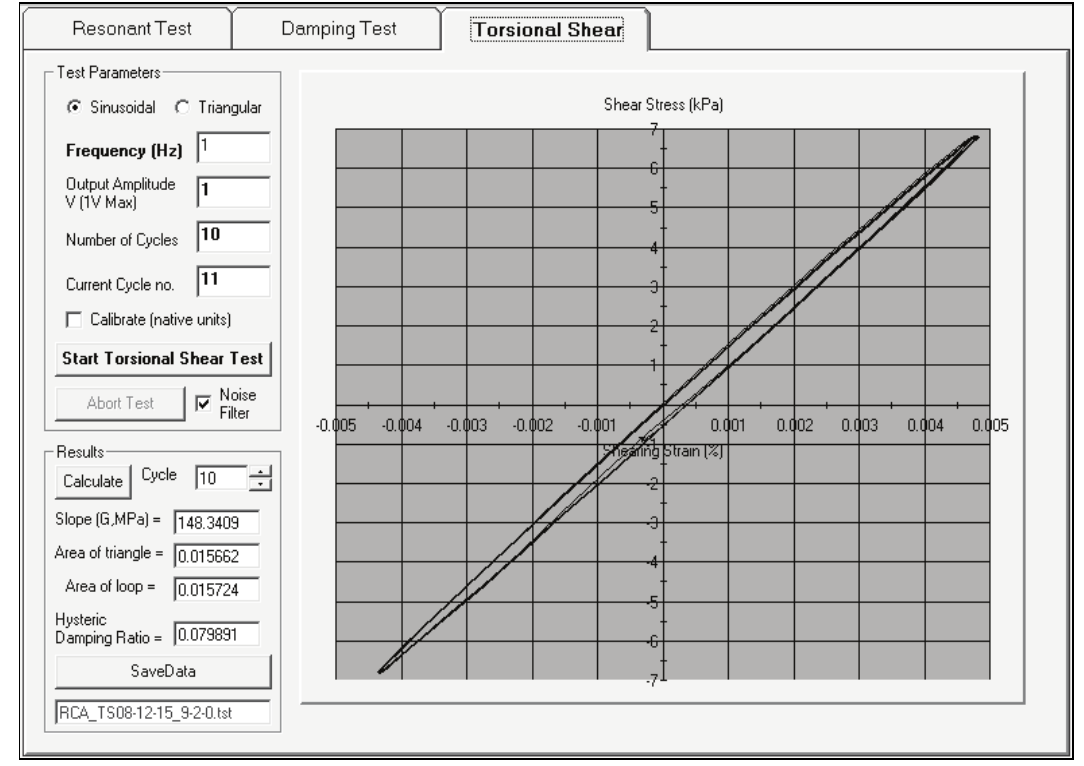
Fig. 7. An example result of hysteresis loop measured in TS test. The dashed line connects both ends of the loop and its slope represents the sample’s shear